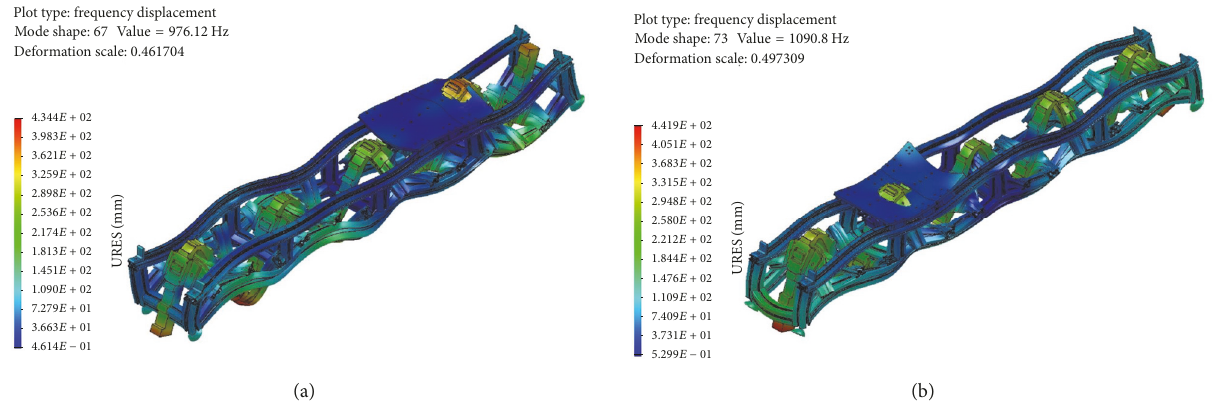
Figure 19: Mode shapes associated with almost exclusive vertical displacement at the bar of the secondary of magnetic circuit: (a) 9th-order mode (mode 67) at position P2 ( 𝑓 ≈ 976 Hz, def. scale ≈ 0.462); (b) 10th-order mode (mode 73) at position P4 ( 𝑓 ≈ 1091Hz, def. scale ≈ 0.497).